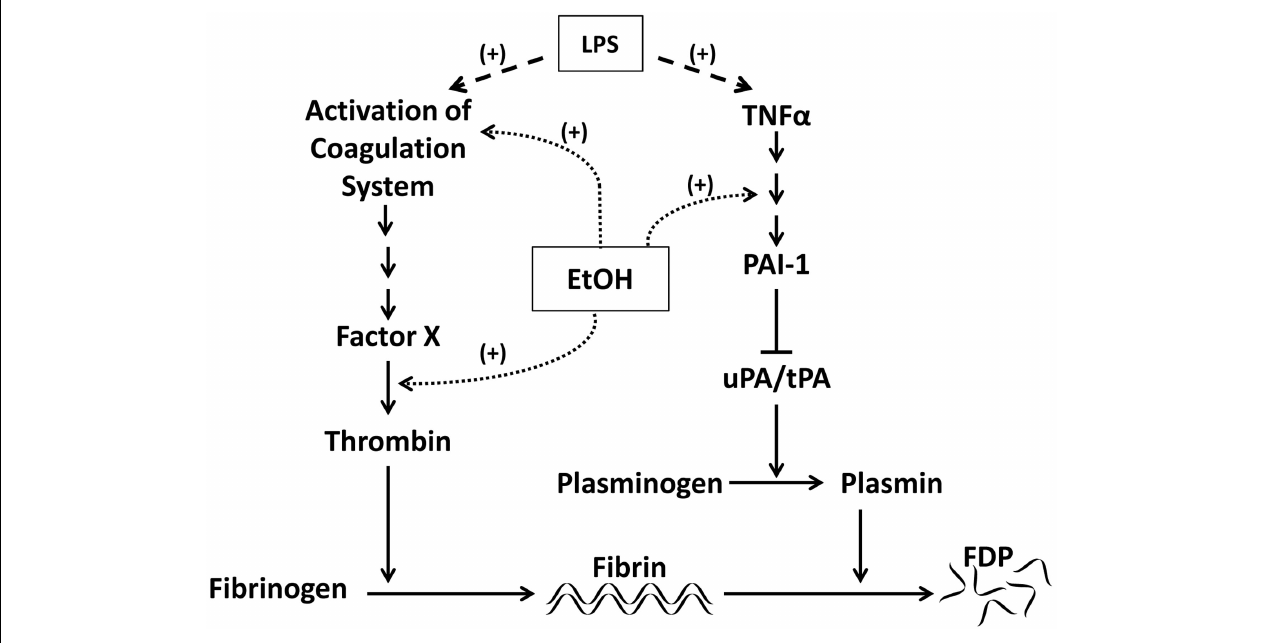
the activation of plasmin. Both ethanol and LPS can modulate signaling downstream of the coagulation cascade, increasing fibrin deposition. Ethanol may also blunt fibrin degradation by altering signaling downstream ofTNF α . LPS can have similar effects on fibrinolysis by stimulating release ofTNF α